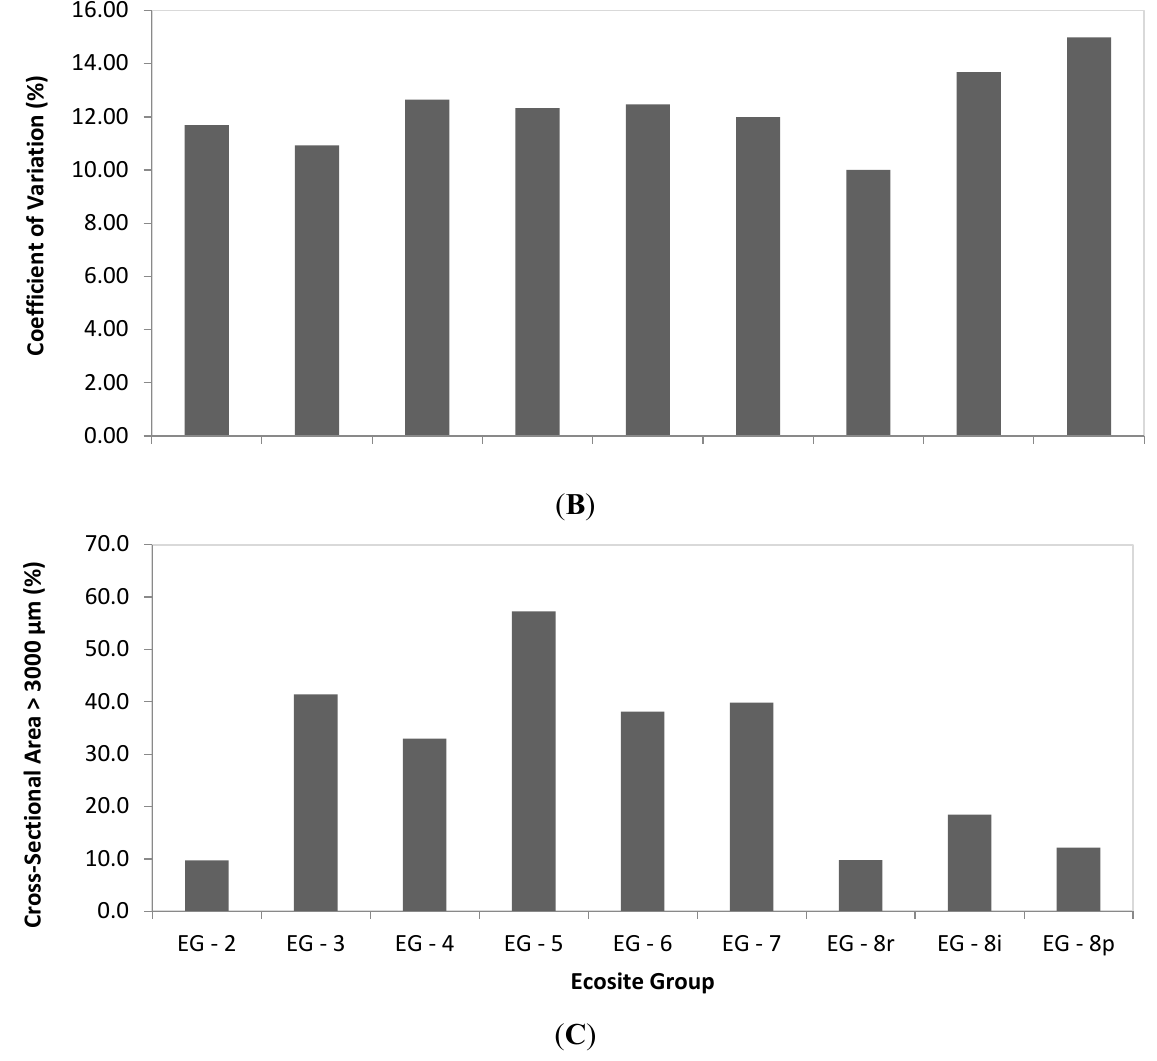
Figure 3. ( A ) stem level mean fibre length ± 1 standard deviation; ( B ) stem-level coefficient of variation of fibre length; and ( C ) percent cross-sectional area ideal fibre length (PIF) at breast height for black spruce ( Picea mariana ) wood samples collected from the boreal forest of northeastern Ontario from